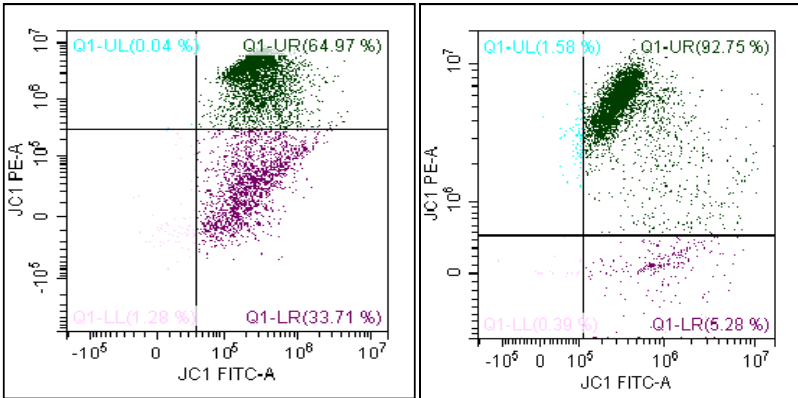
Figure 1. Representative dot plot of JC-1 staining. The quadrant Q1-LR shows the percentage of spermatozoa with low mitochondrial membrane potential (FITC-positive and PE-negative).